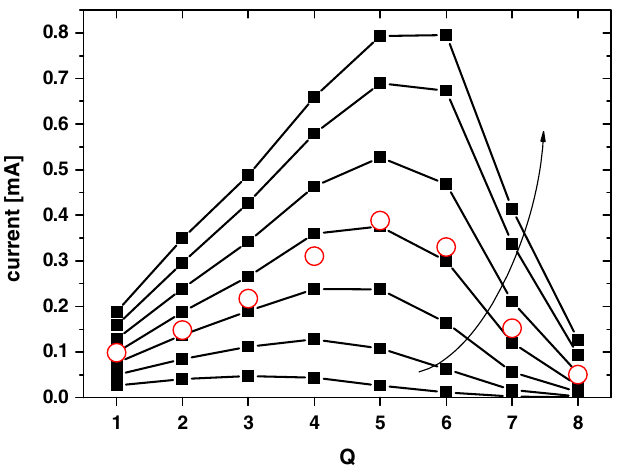
FIG. 1. (Color) Charge-state distributions of the extracted Ne ions as a function of the gas pressure. The arrow shows the direction of increasing gas pressure. Curves correspond to the gas pressures ð 3 : 8 ; 4 : 8 ; 5 : 8 ; 6 : 8 ; 7 : 6 ; 8 : 5 ; 9 : 3 Þ (cid:1) 10 (cid:2) 7 mbar . Open circles represent experimentally measured extracted ion currents from the KVI-AECRIS with the source optimized for the maxi- mal Ne 6 þ